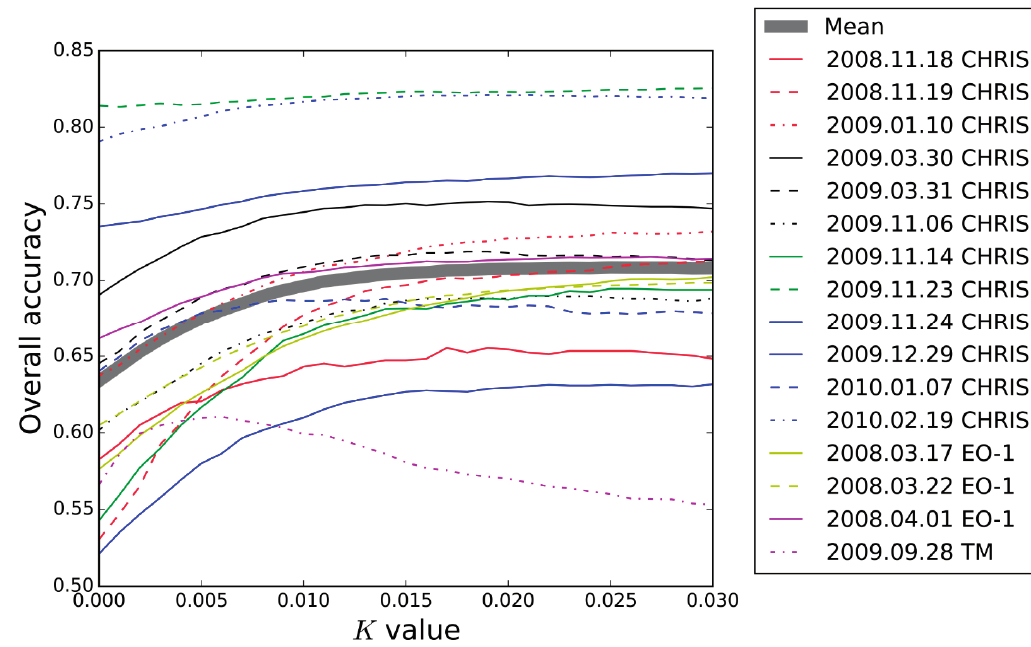
Figure 4. Overall accuracies of downscaled maps with various K values. High-resolution satellite images are used to verify the downscaling results based on different snow cover areas. Each line represents an accuracy change due to the adjustment of the K value. Accuracy changes have a similar trend with increasing K value.